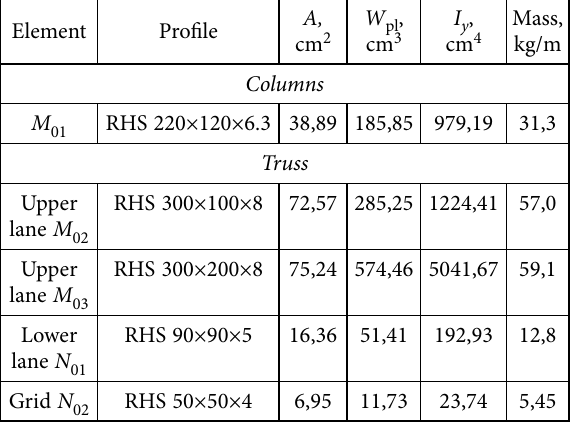
Table 3. Chosen data on the framing